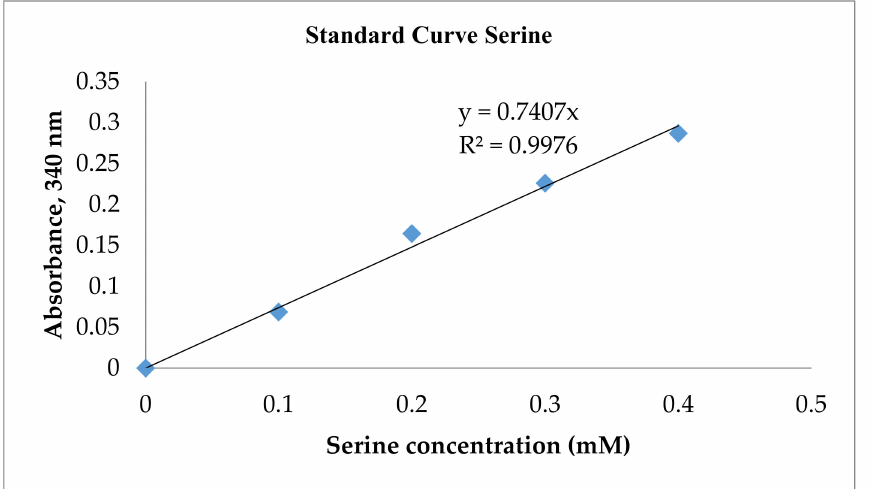
Figure 2. Standard curve serine for measuring peptide